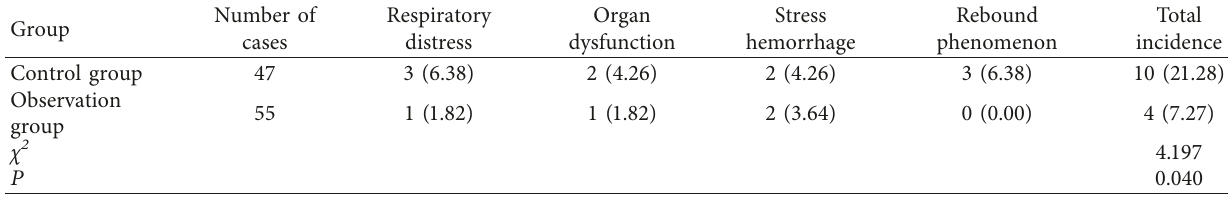
Table 5: Complications in the two groups of patients ( n , %).